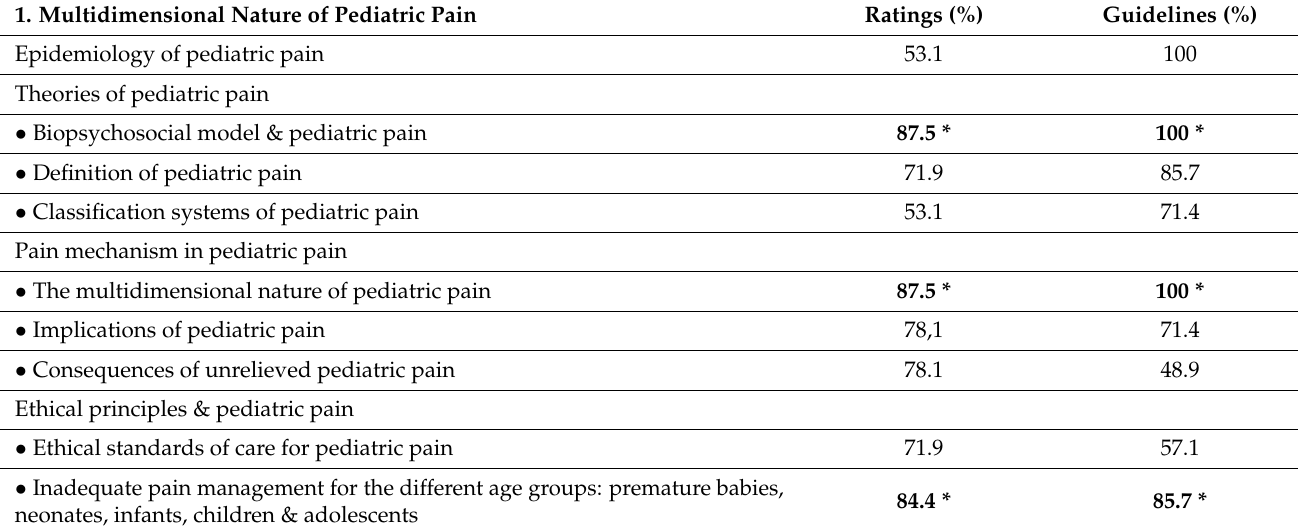
Table 3. Comparison of experts’ ratings and